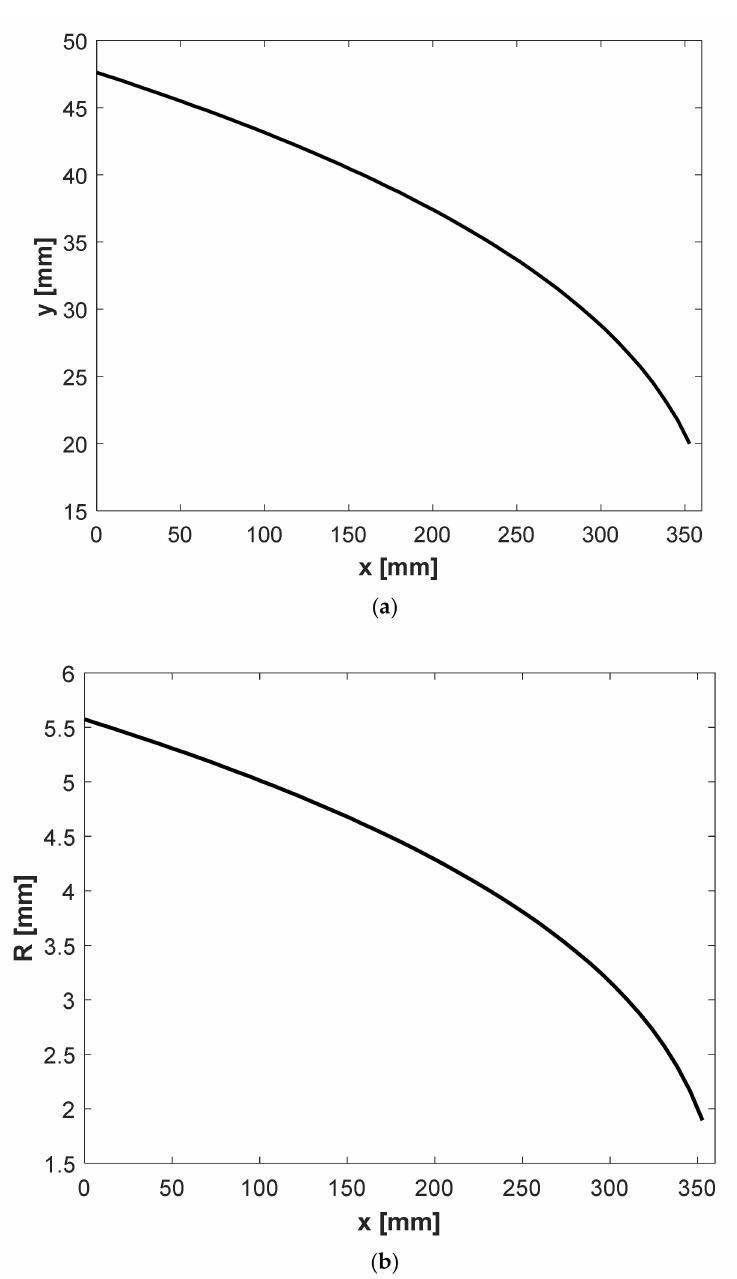
Figure 9. ( a ) Change of design parameter y ( x ) with respect to x and ( b ) change of manifold radius R with respect to x for a Cross polypropylene (parameters in Table 1) using the proposed model with a circular